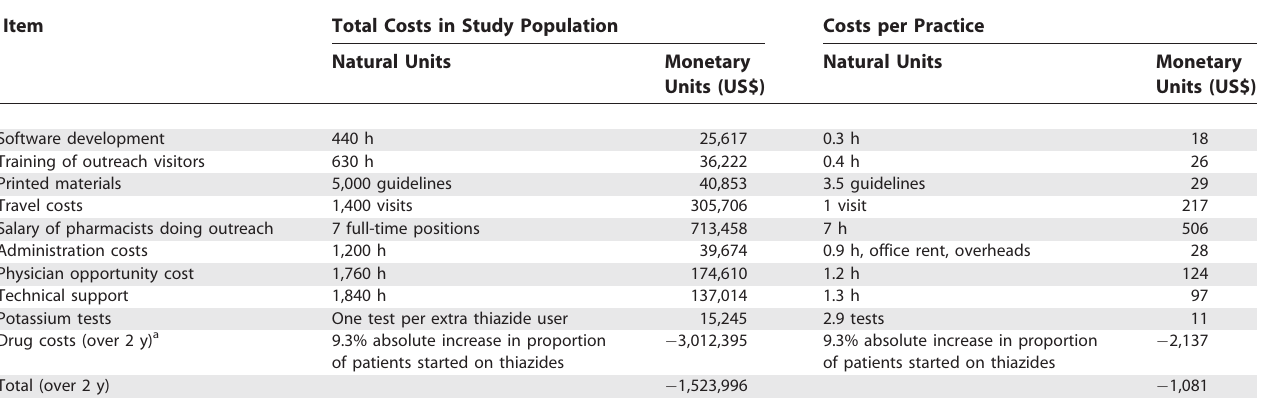
Table 6. Costs Related to the Intervention in Model for Scaling Up to National Program